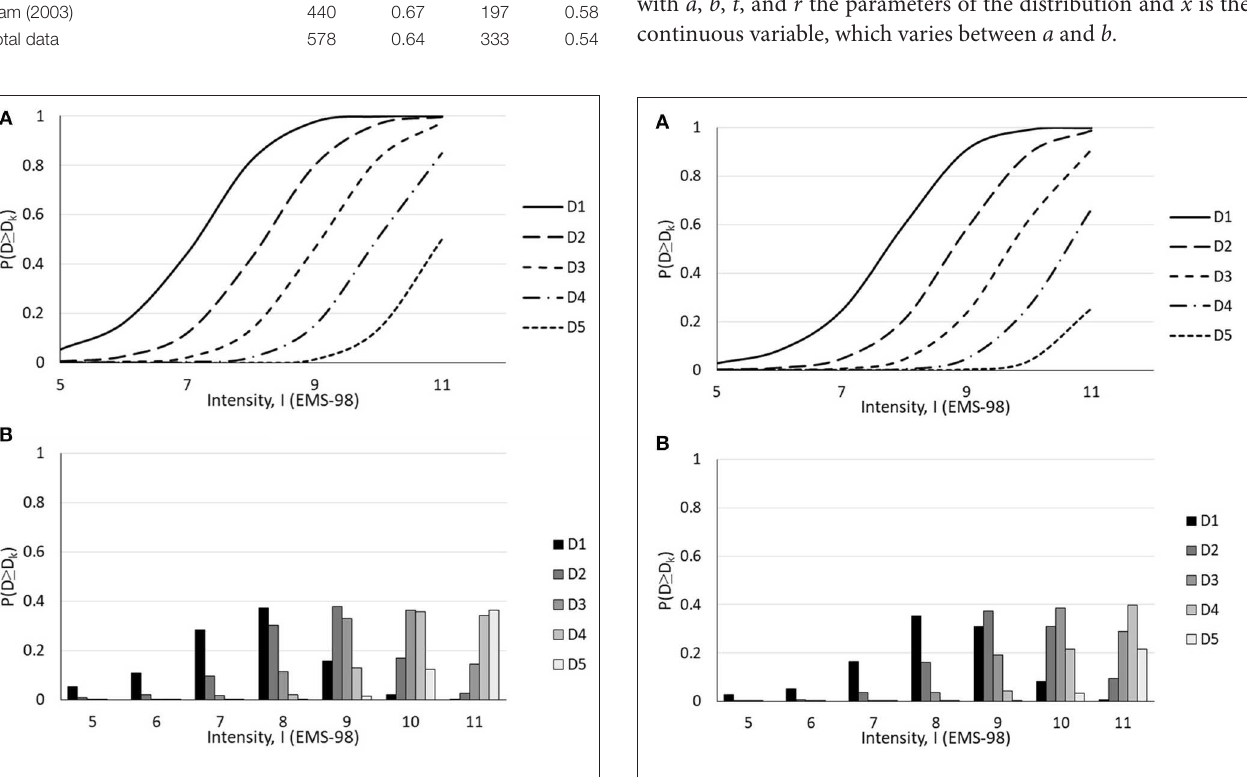
FIGURE 11 | (A) Fragility curves and (B) damage distribution as a function of intensity for Sarpol-e-zahab and Bam CM buildings (original).